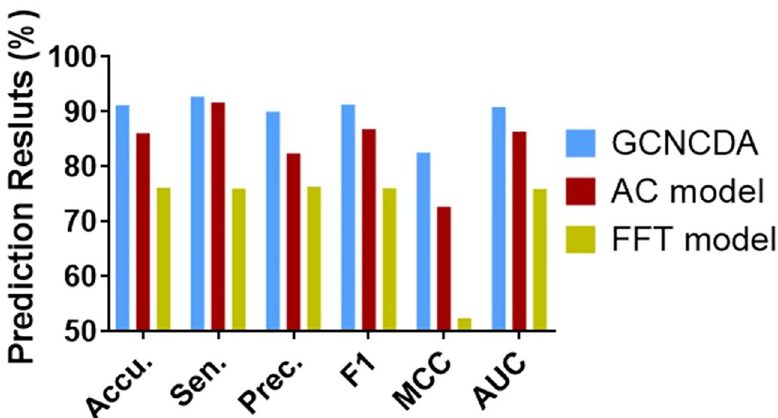
Fig 5. Comparison of results of different feature extraction models on circR2Disease